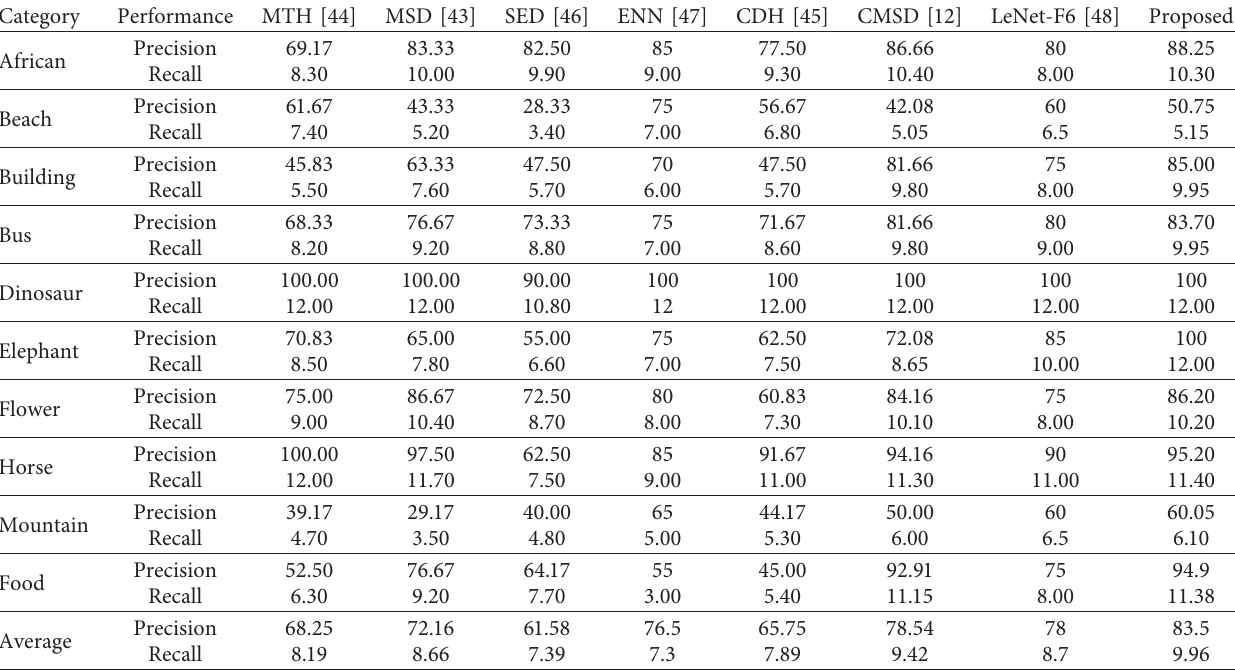
Table 7: Category-wise performance comparison of NRLGO at Corel 1k with state-of-the-art descriptors. Category African Precision Beach